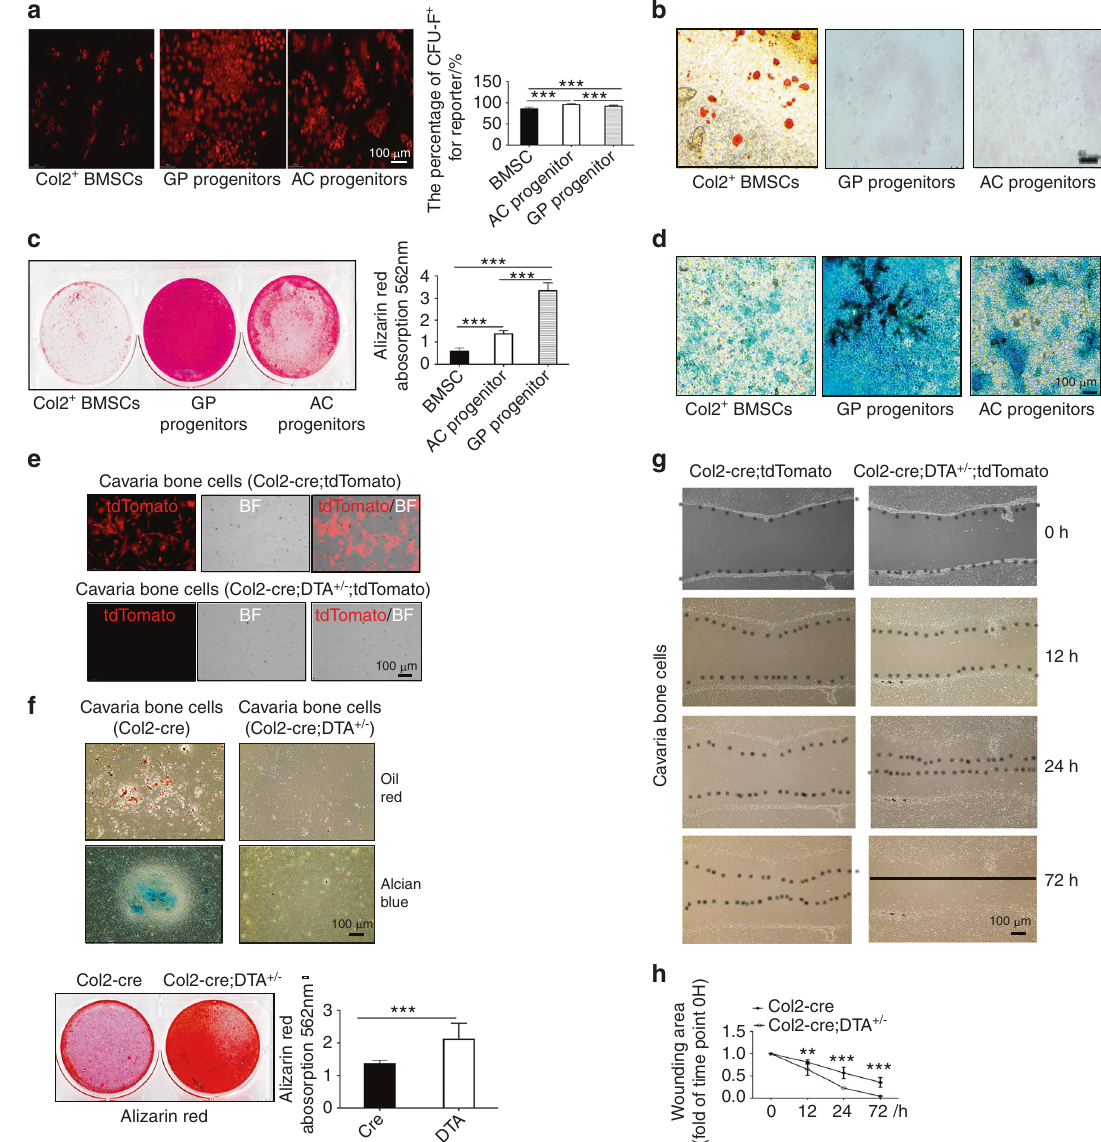
Fig. 7 Col2-positive progenitors from different tissues have varied differentiation potential. a CFU-F assay of Col2 + bone marrow stem cells (BMSCs), GP progenitors and AC progenitors showing that every cell type can form CFU colonies. b Adipogenic differentiation of Col2 + BMSCs, GP progenitors and AC progenitors. c Osteogenic differentiation of Col2 + BMSCs, GP progenitors and AC progenitors. d Chondrogenic differentiation of Col2 + BMSCs, GP progenitors and AC progenitors. e Merged pictures showing Col2 + cells cultured from the calvaria of Col2- cre;tdTomato and Col2-cre;DTA + / − ;tdTomato newborns. Note that few Col2 + cells were detected in the Col2 + cell ablation group, con fi rming the effectiveness of the cell ablation technique. f Assay of the trilineage differentiation of cells cultured from the calvarial bone of Col2-cre and Col2-cre;DTA + / − newborns ( n = 3 mice per condition; three independent experiments). g Different migration abilities of cells cultured from Col2-cre and Col2-cre;DTA + / − newborns. h Quantitative measurements of migration ability based on the results shown in ( g ) ( n = 3 mice per condition; three independent experiments). All the data are reported as the means ± s.ds. The statistical signi fi cance was determined by one- way ANOVA and Student ’ s t test. * P < 0.05, ** P < 0.01, *** P < 0.000 1, NS not statistically signi fi